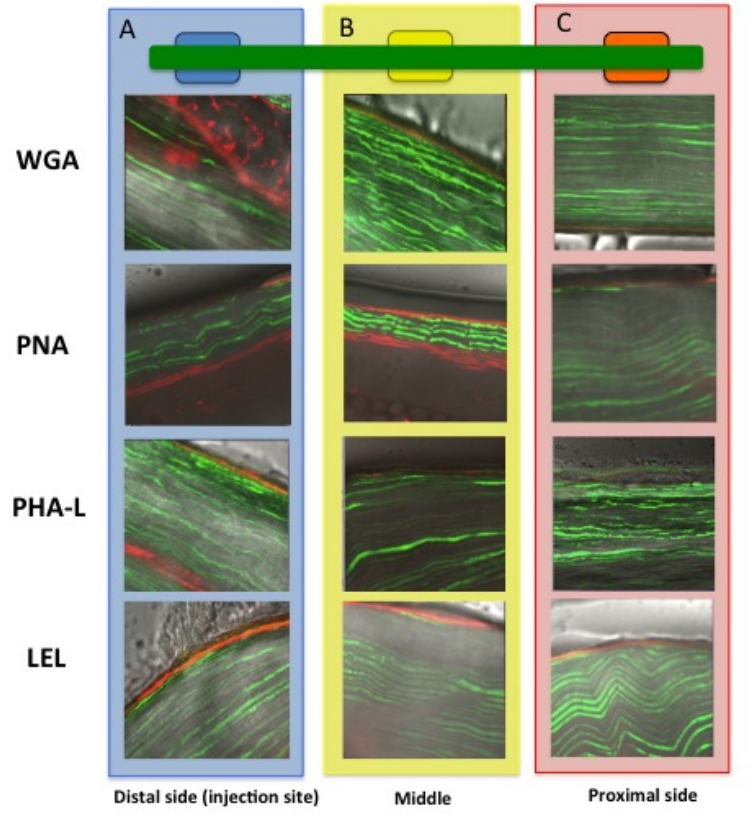
Figure 6. Binding mode after in vivo local administration. The fluorescence signal in nerves from Thy-1 YFP mice (YFP in green and Cy5 in red) was traced from ( A ) the injection site to ( B ) the middle and ( C ) the proximal side of the nerve. In all cases, staining of the epineurium was observed with a decrease in signal when the distance from the injection site